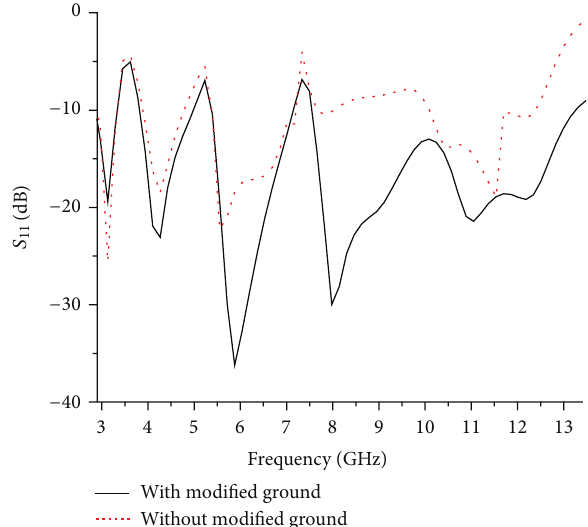
Figure 3: The effect of the modified ground